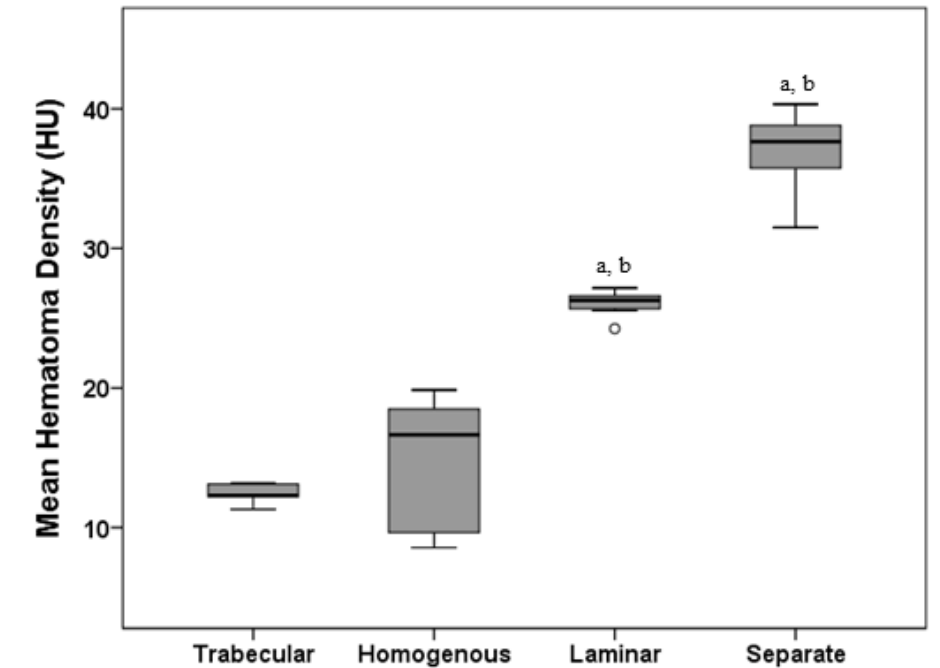
Figure 2. The distribution of MHD across four types of CSDHs based on internal structure. A significant difference was found using Dunn’s post-hoc test after Kruskal–Wallis test. a p < 0.05 compared to trabecular; b p < 0.05 compared to homogenous. Note: Values more than 1.5 IQRs but less than 3 IQRs from the end of the box are labeled as outliers (o).